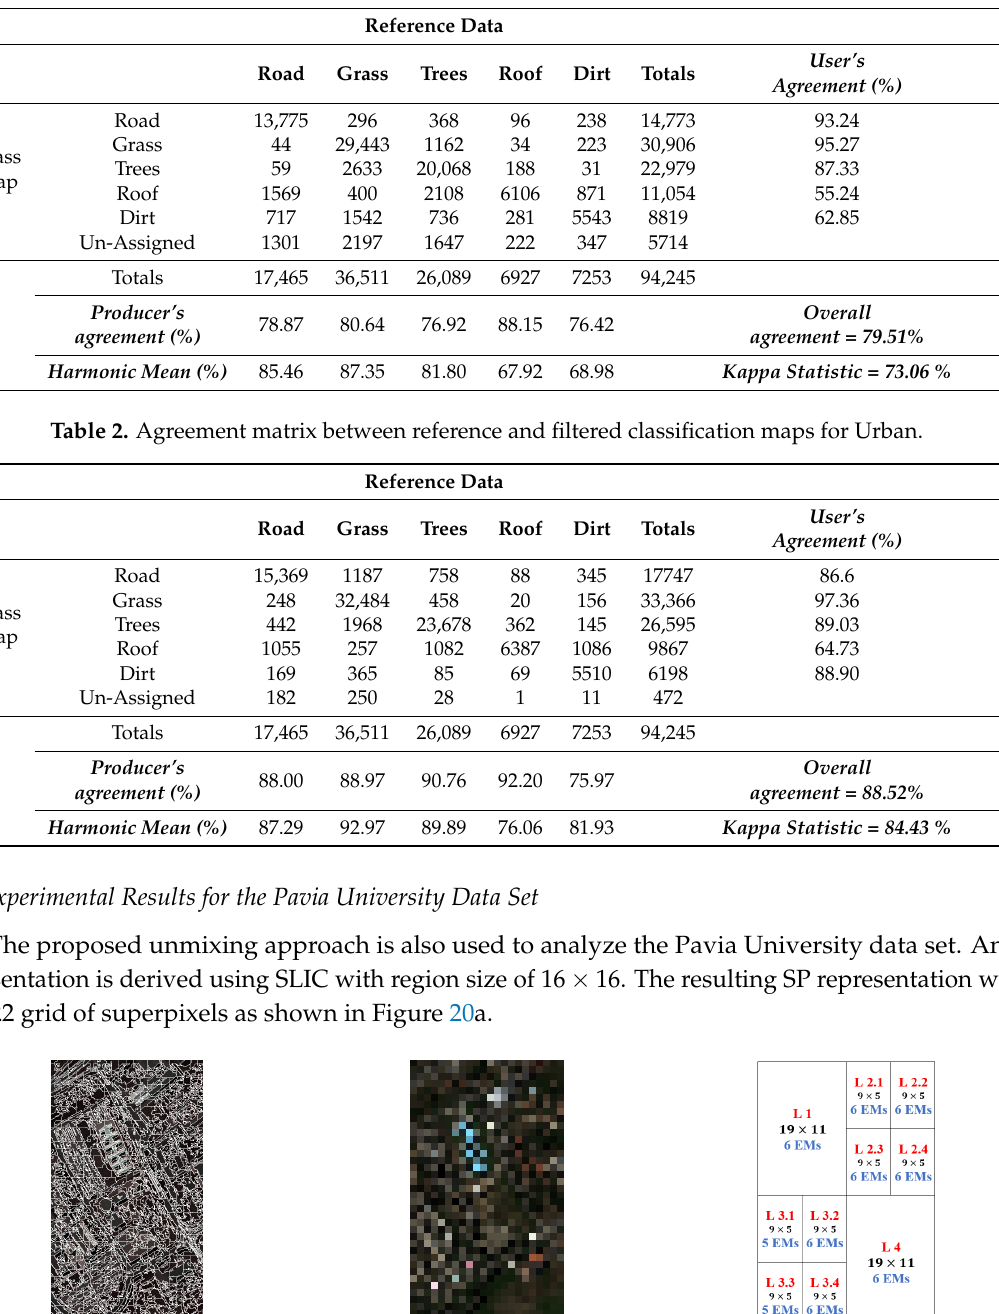
Table 1. Agreement matrix between reference and generated classification maps for Urban.